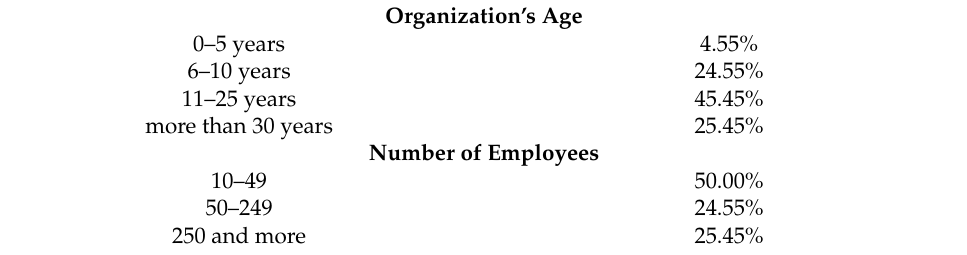
Table 2. Characteristics of the surveyed enterprises (n = 110).